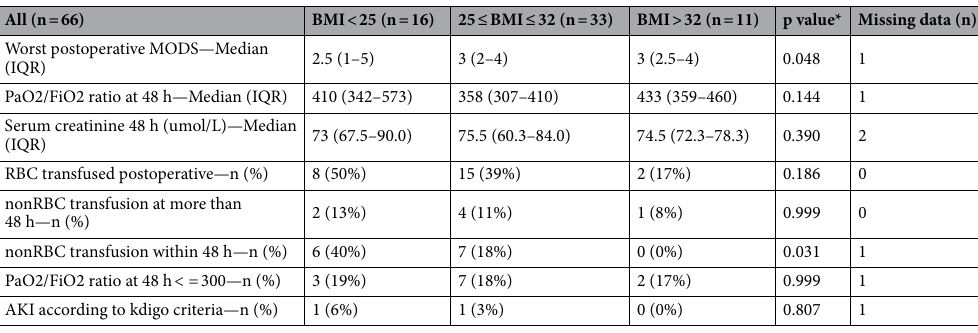
Table 1. Pre- and post-operative characteristics. (*)—Tests among BMI groups were conducted by exact test for categorical variables, and ANOVA or non-parametric Kruskal–Wallis test for continuous variables. Data are presented as n (%) for categorical variables and mean (standard deviation, STD) or median (interquartile range, IQR) for continuous variables. ACE, Angiotensin Converting Enzyme; AKI, Acute Kidney Injury; CABG, Coronary artery Bypass Grafting; CCS, Canadian Cardiovascular Society; Hct, Haematocrit; FiO2, Fraction of Inspired Oxygen; KDIGO, The Kidney Disease Improving Global Outcomes; MABP, Mean Arterial Blood Pressure; MODS, Multiorgan Dysfunction Syndrome; NYHA, New York Heart Association; PO2, Partial Pressure of Oxygen; RBC, Red Blood Cells; VD, Vessel